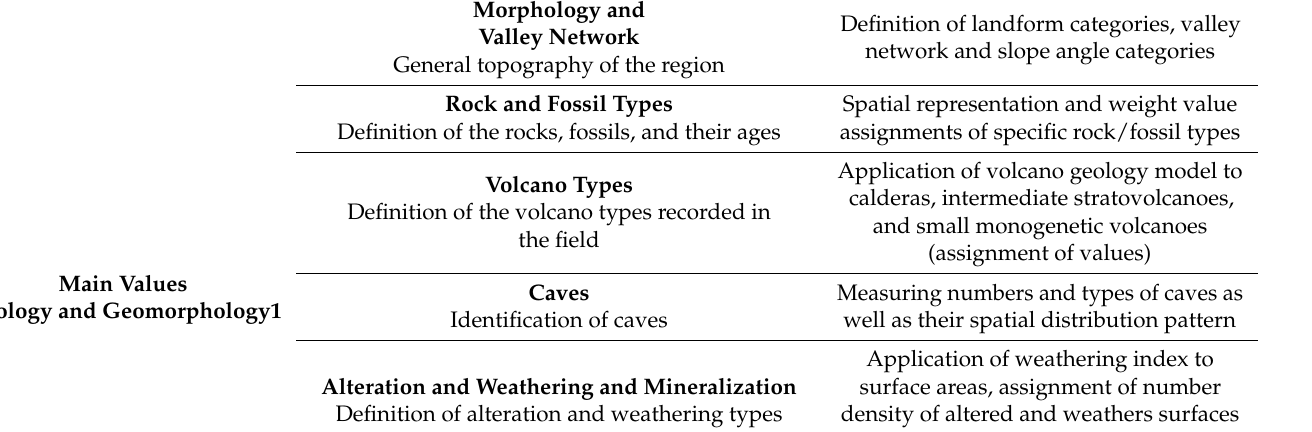
Table 1. Table of the proposed conceptual framework of the geodiversity of the Coromandel Peninsula. The table contains two main objects: geology and geomorphology, while additional objects are hydrology, climate, human and biological footprint. Every object contains several elements, which describe it in more